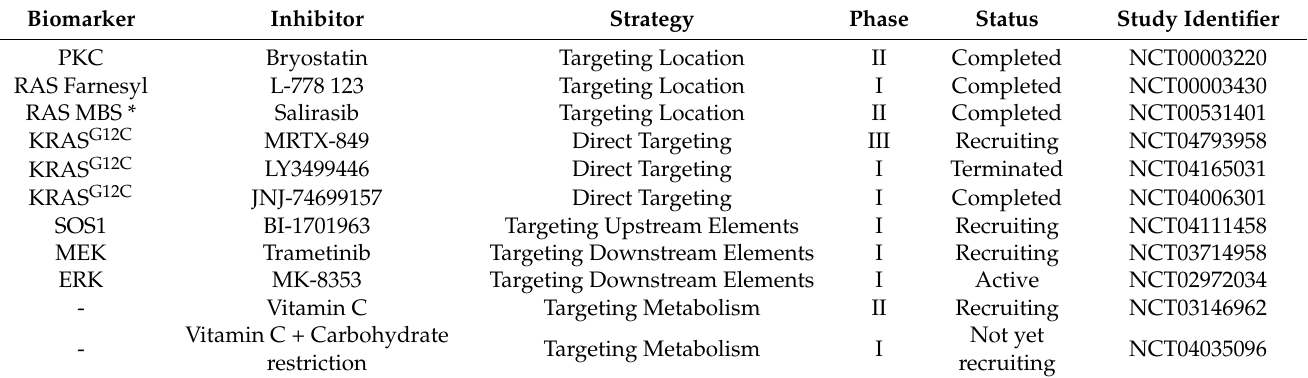
Table 2. Clinical trials testing Ras-GTPase inhibitors in CRC patients with KRAS or BRAF mutations.